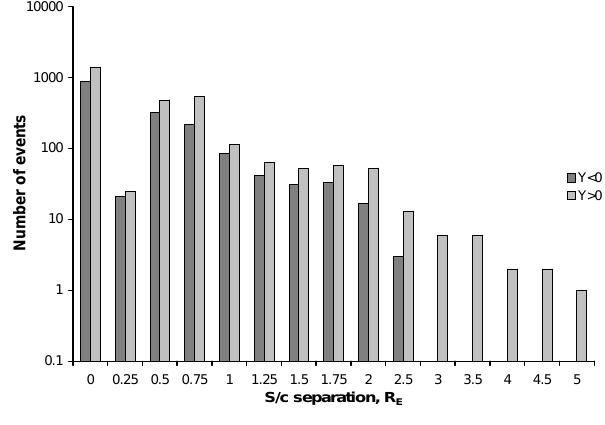
Fig. 4. Distributions of spacecraft separations in the analyzed set for dusk and dawn subsets. Note that both vertical and horizontal scales are